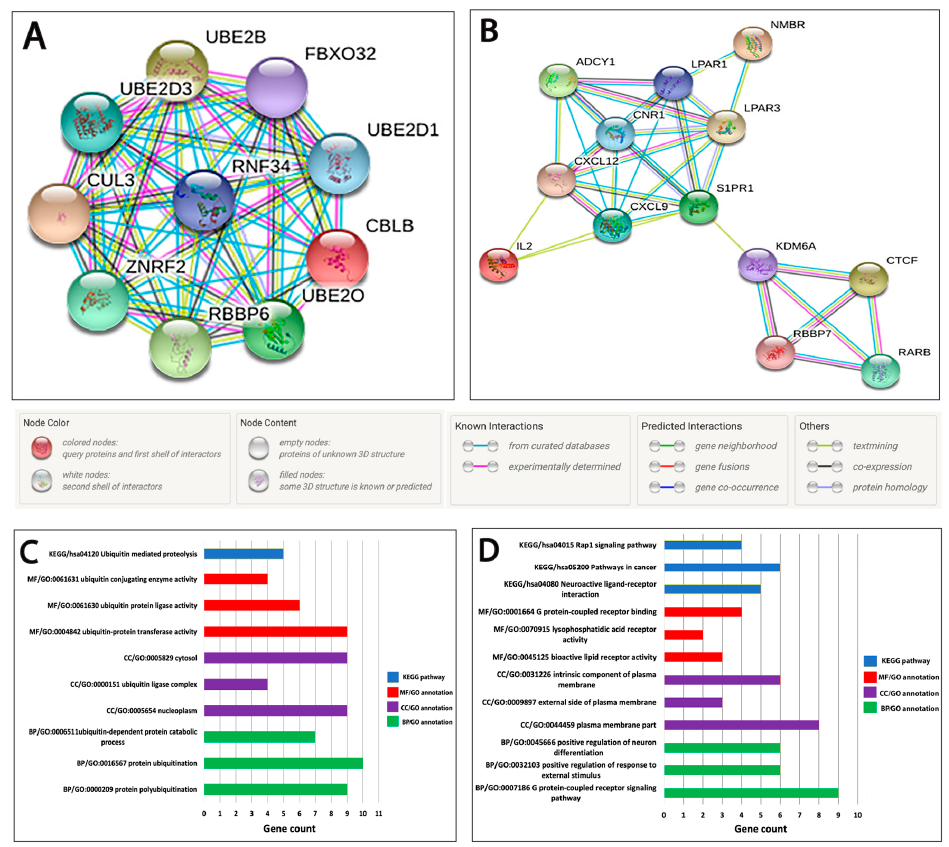
Figure 3. The PPI networks, GO annotations, and KEGG pathway enrichment analysis of identified hub genes of miR-141-3p, miR-181b1-5p, and miR-23b-3p. The PPI networks were created using the STRING online database for the identified hub genes obtained from the Cytoscape plugin MCODE analysis. ( A ) PPI network of the 10 hub genes in cluster 1; ( B ) PPI network of the 13 hub genes in cluster 2; p < 1.0 × 10 − 16 and p < 2.49 × 10 − 14 for the entire PPI network of modules 1 and 2, respectively; ( C ) bar plot illustrating the GO annotation and KEGG pathway enrichment analyses for cluster 1 hub genes; ( D ) bar plot illustrating the GO annotation and KEGG pathway enrichment analysis for cluster 2 hub genes. The blue, red, purple, and green bars represent the enrichment analysis results of KEGG, MF, CC, and BP, respectively. 2.7. High Expression of miR-141 and miR-181b Is Associated with Worse Overall Survival (OS) in Breast Cancer Patients We next examined the prognostic value and clinical significance of miR-141, miR-181b, and miR- 23b expression in breast cancer using the Kaplan–Meier (KM) plotter miRNA breast cancer online database [27]. Among datasets included in the KM plotter, we employed the Molecular Taxonomy of Breast Cancer International Consortium (METABRIC) cohort dataset, which includes data from 1262 patients, to assess the association between the three studied miRNAs and OS in breast cancer patients [28]. In agreement with our results, for all 1262 patients, the OS is significantly lower in patients with high expression of both miR-141 (HR = 1.43, 95% CI = 1.17–1.74, p = 0.00037) and miR-181b (HR = 1.47, 95% CI = 1.19–1.82, p = 0.00029) compared with patients with low expressions (Figure 4A,B). No statistically significant difference was observed in the OS time between breast cancer patients with low and high expression of miR-23b (HR = 1.14, 95% CI = 0.94–1.39, p = 0.18). Hence, the KM plotter results emphasized the prognostic significance of miR-141 and miR-181b in breast cancer.